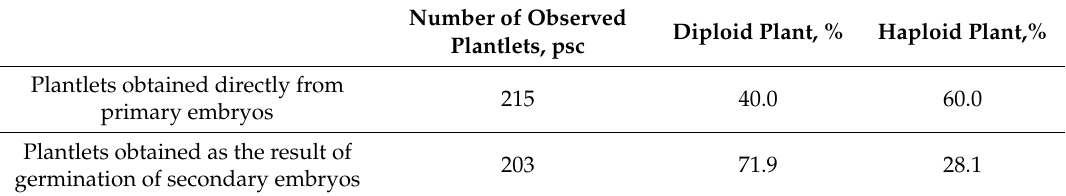
Table 4. Ploidy level of plantlets obtained from primary microspore-derived embryos and secondary turnip